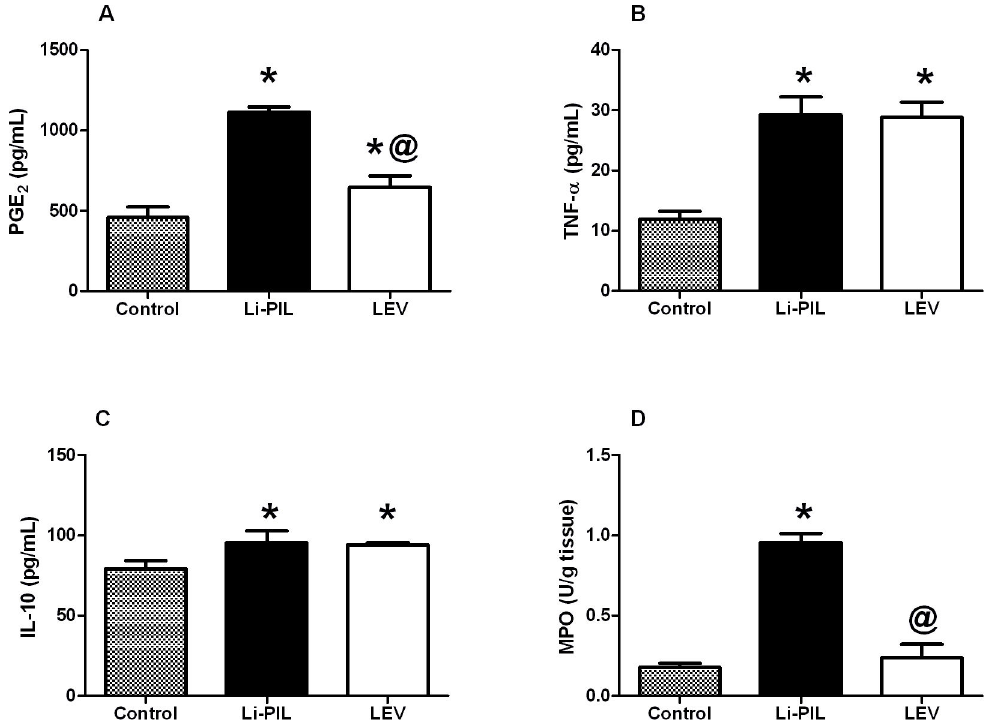
Figure 2. Effect of levetiracetam (LEV, 500 mg/kg i.p.) on hippocampal prostaglandin (PG)E (TNF)-α (B), interleukin (IL)-10 activity (C), and myeloperoxidase (MPO) (D) in lithium-pilocarpine (Li-PIL)-induced convulsion in rats. Values are means ± S.E.M. of 6 rats. As compared to control (*) and Li-PIL ( @ ) groups. Comparisons were carried out using one-way ANOVA followed by Student–Newman–Keuls Multiple Comparisons Test, P <0.05.